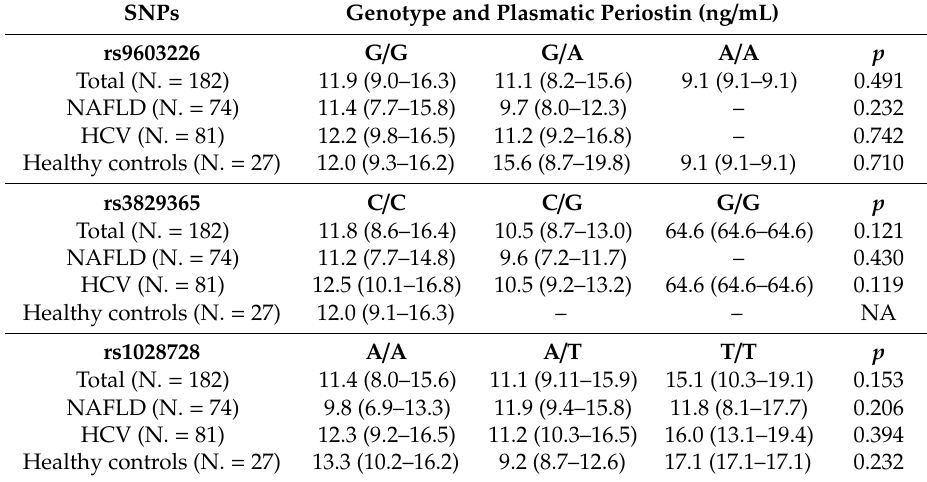
Table 6. Periostin plasmatic concentrations according to POSTN gene polymorphisms. Median and interquartile range are reported. The p value refers to the correlation between the genotype of the single polymorphisms and periostin circulating